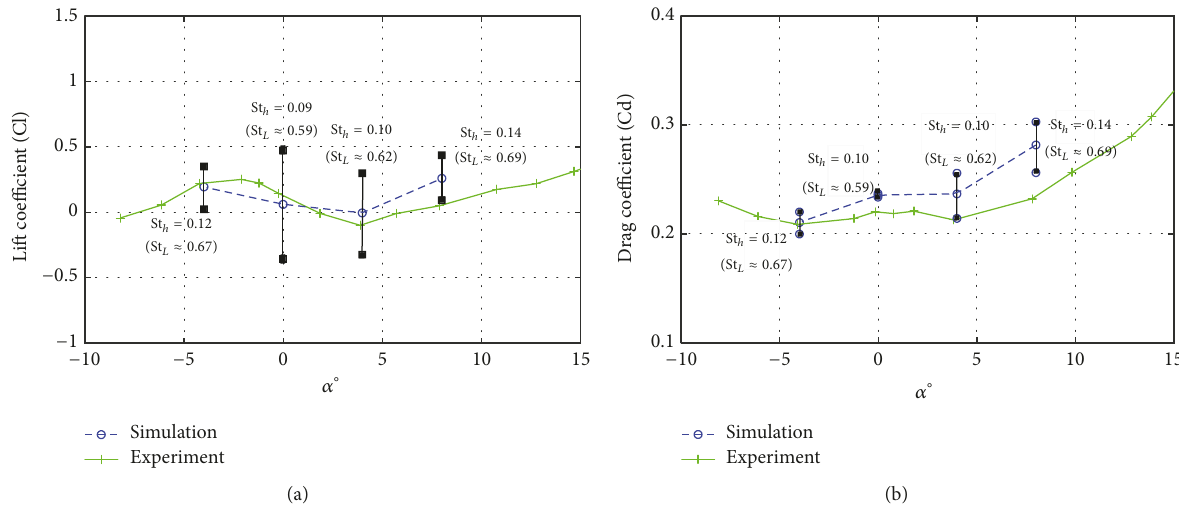
Figure 9: Lift (a) and drag (b) coefficient including the amplitude of oscillations (black vertical bars) and Strouhal number of shedding